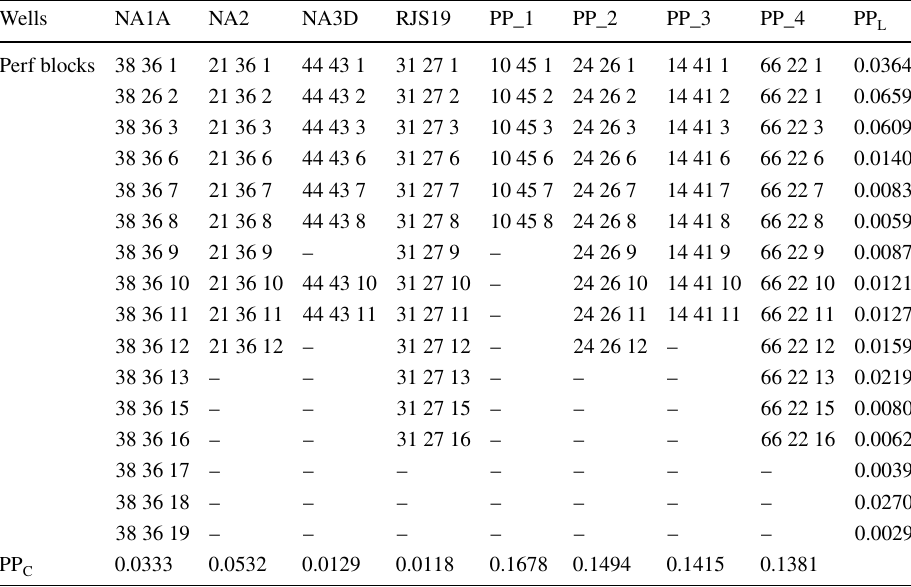
Table 1 UNISIM-I-D and PP wells with their respective perforation blocks,